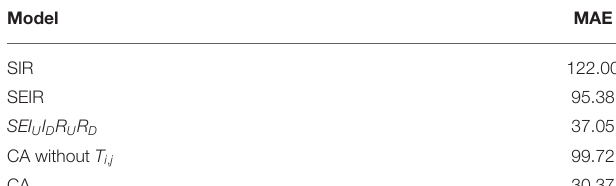
TABLE 4 | MAE of the models on the outbreak data of Heilongjiang.